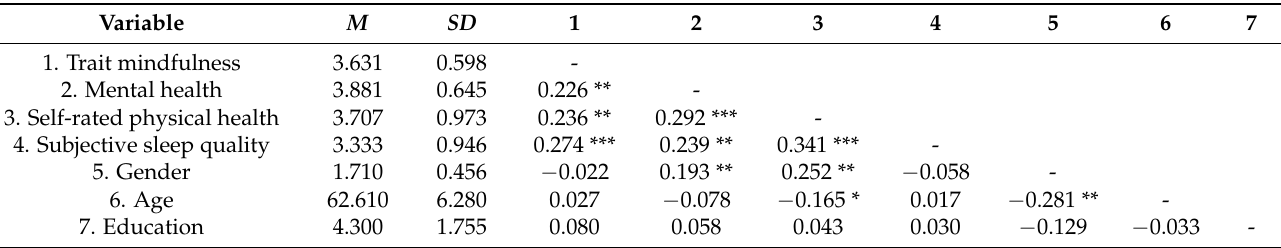
Table 1. Descriptive statistics and correlations of study variables.